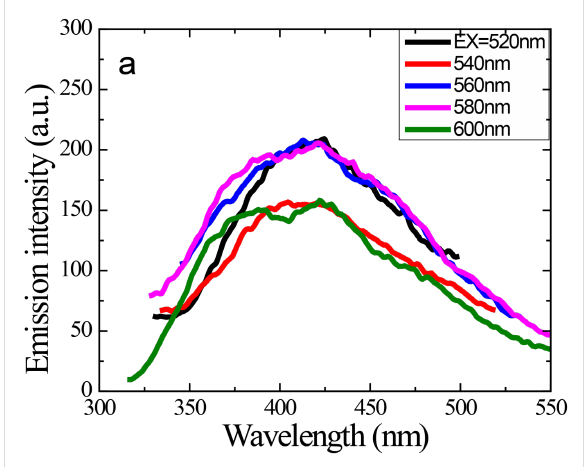
Figure 7: Upconverted PL spectra of TCND-1 in dry acetone at excita- tion wavelengths in range between 520 and 600